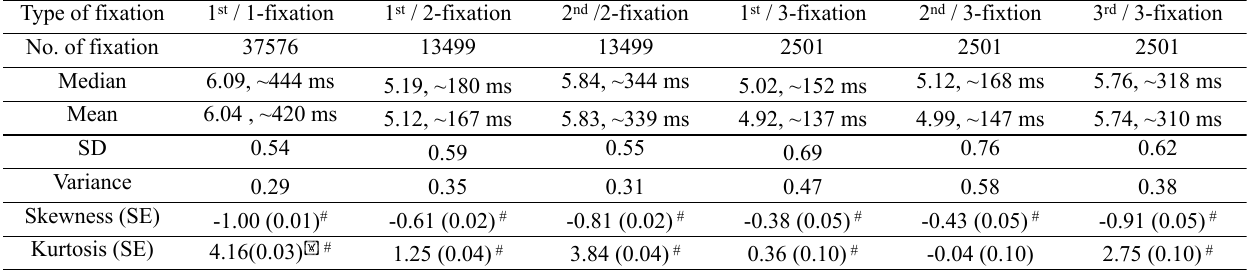
Note. Median and mean durations are also presented in ms. The symbol ‘#’ indicates that |skewness/SE skweness| >2 and | Kurtosis /SE kutosis| > 2, which is the criterion used for a non-normality.